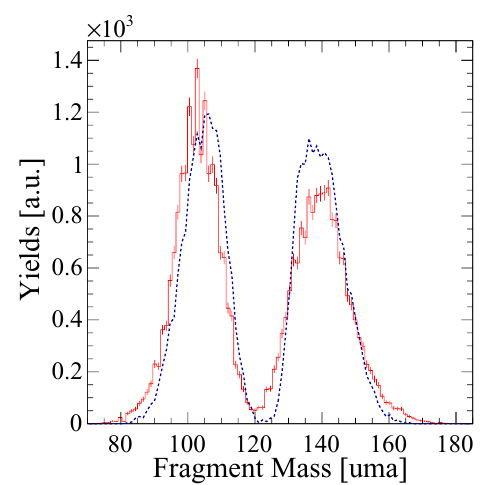
Figure 5. Distributions of post-evaporation masses of fragments issued from spontaneous fission of a 252 Cf source. The red line is the data measured with the FALSTAFF setup while the blue line is the result of a GEANT4 simulation of the setup using GEF.